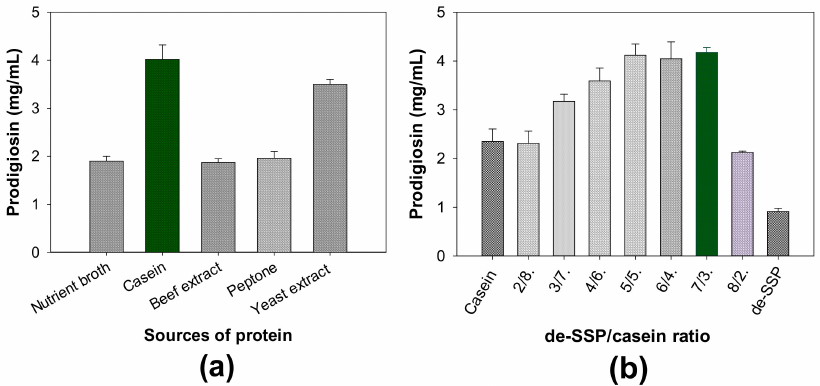
Figure 2. The influence of protein sources ( a ) and de-SSP/casein ratio ( b ) on PG productivity via fermentation by S. marcescens TNU01. Carbon/nitrogen sources in different proteins were combined with de-SSP at a ratio of 3.0/7.0 ( a ) and de-SSP was combined with casein in various ratios ranging from 2/8 to 8/2 ( b ) were used at the concentration of 1.60% in a liquid medium containing 0.03% K 2 HPO 4 and 0.05% CaSO 4 . Oral casein and oral de-SSP were also fermented for comparison. The fermentation was performed for two days with no light, at 150 rpm and 25 ◦ C. The error bars in the figures are standard errors